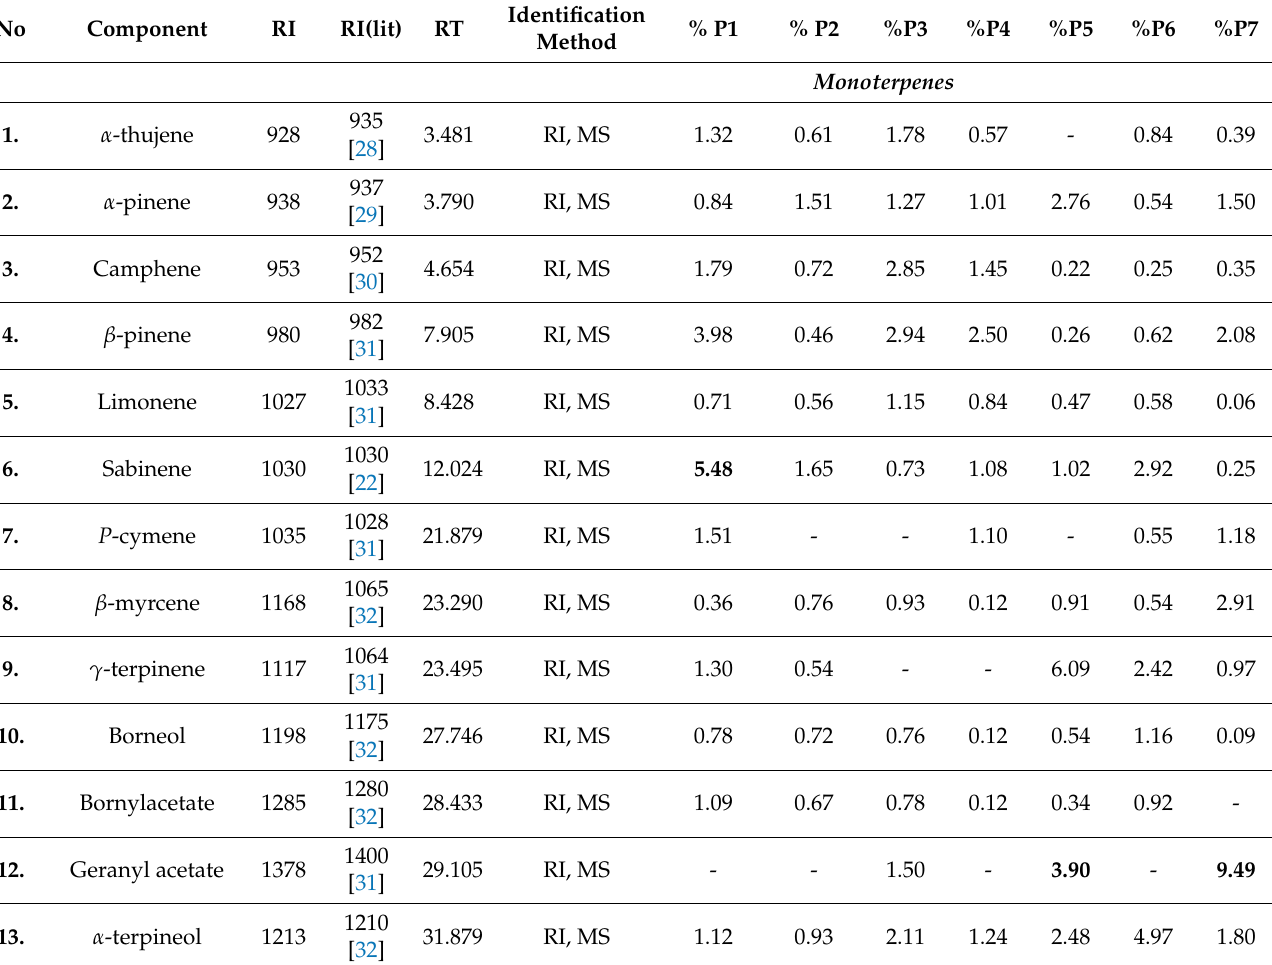
Table 1. Essential oils chemical composition of seven the Polygonum